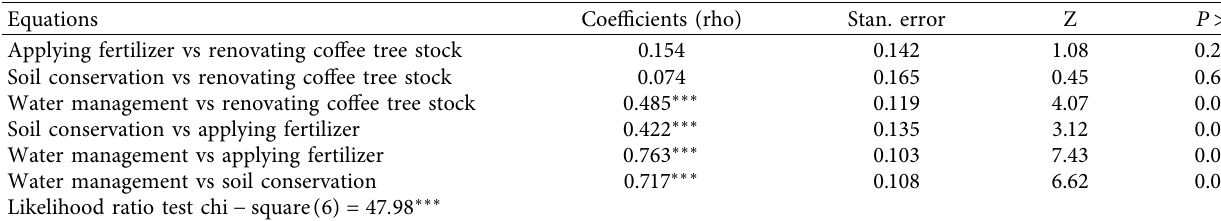
Table 2: Correlation coefficients for MVP adoption